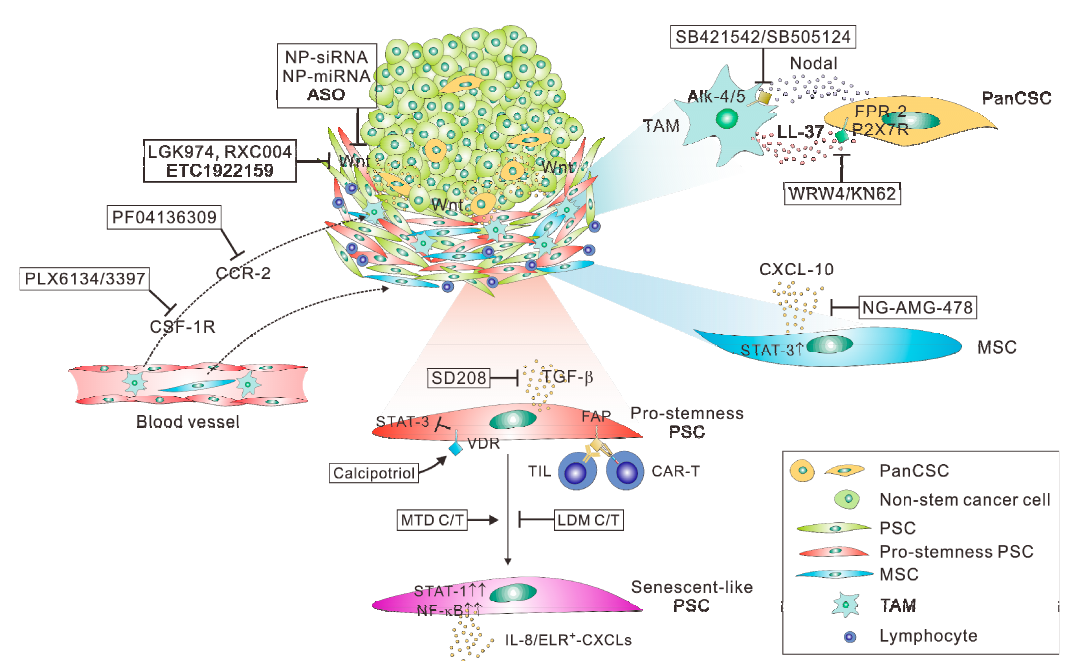
Figure 2. Potentially viable routes to targeting panCSCs and pancreatic cancer stemness. Therapeutics targeting Wnt-related pro-stemness niches, such as the porcupine inhibitors (LGK974, RXC004, and ETC-1922159), nanoparticle (NP)-formulated siRNA or miRNA, and synthetic antisense oligonucleotides (ASO), can prevent activation of Wnt signaling in panCSCs and non-stem cancer cells. Compared with panCSCs, the pro-stemness pancreatic stellate cells (PSCs) or mesenchymal stem cells (MSCs) residing in the tumor stroma or around blood vessels are more accessible to intravenously delivered therapeutics, such as the small-molecule inhibitor of TGF- β (SD208) or VDR signaling (calcipotriol) and novel immunotherapeutic agents, including DNA vaccine of FAP or other PSC-specific antigens, which elicits PSC-specific tumor-infiltrating T cells (TILs), FAP-directed CAR-T cells, and other types of engineered immune cells targeting PSCs. The intra-stromal and intra-tumoral delivery of PSC- or MSC-targeted therapeutics can be enhanced by nanoparticle formulation, such as the nanoghost (NG)-encapsulated CXCL-10 inhibitor AMG487 and nanocarrier-formulated sTRAIL gene therapy. The recruitment of pro-stemness tumor-associated macrophages (TAMs) residing into the PDAC stroma can be inhibited by small-molecules inhibitors of CSF-1R (PLX6134 or PLX3397) or CCR-2 (PF04136309). The TAM − panCSC crosstalk can be inhibited by small-molecular inhibitors of the Nodal / Activin-A receptors Alk-4 and Alk-5 (SB421542 and SB505124) or the inhibitors of the LL-37 receptors FRP-2 (WRW4) and P2X7R (KN62). Finally, low dose metronomic (LDM) chemotherapy can attenuate therapy-induced PSC activation and secretion of pro-stemness chemokines through chronic activation ( ↑↑ ) of CXCLs, serving as an immediately clinically deployable strategy to indirectly targeting panCSCs. Note that antibody therapeutics with potential activity in inhibiting panCSCs and/or their niches are clinical viability in PDAC.